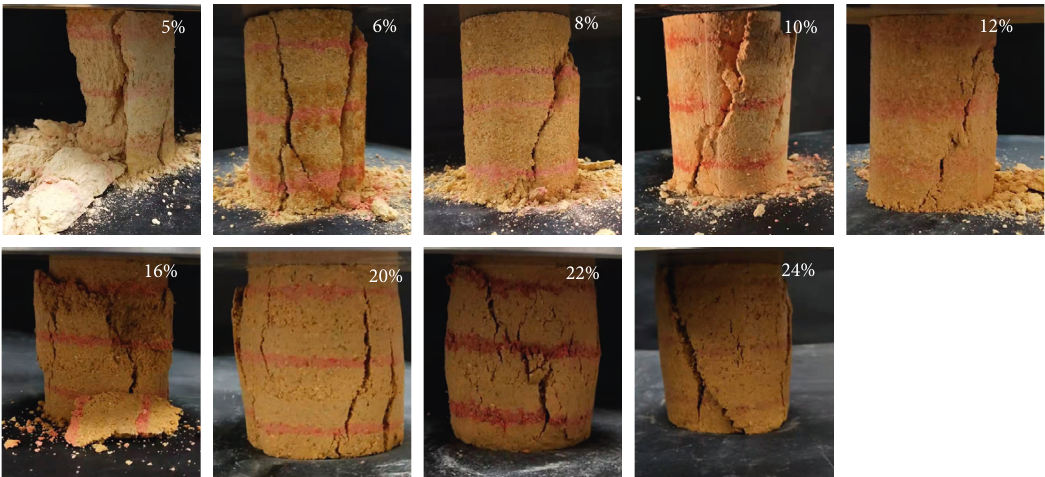
Figure 3: Failure modes of granite residual soil samples with different moisture content under uniaxial